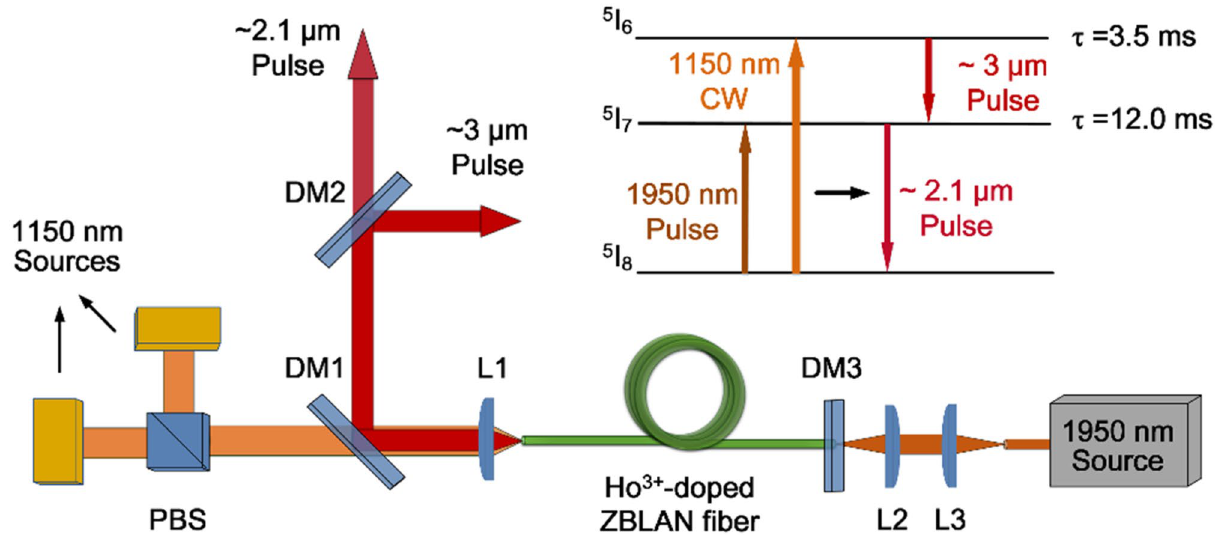
Figure 5. Experimental setup of the power controllable gain-switched dual-waveband Ho 3+ -doped ZBLAN fiber laser. Included is a simplified energy level diagram of this laser